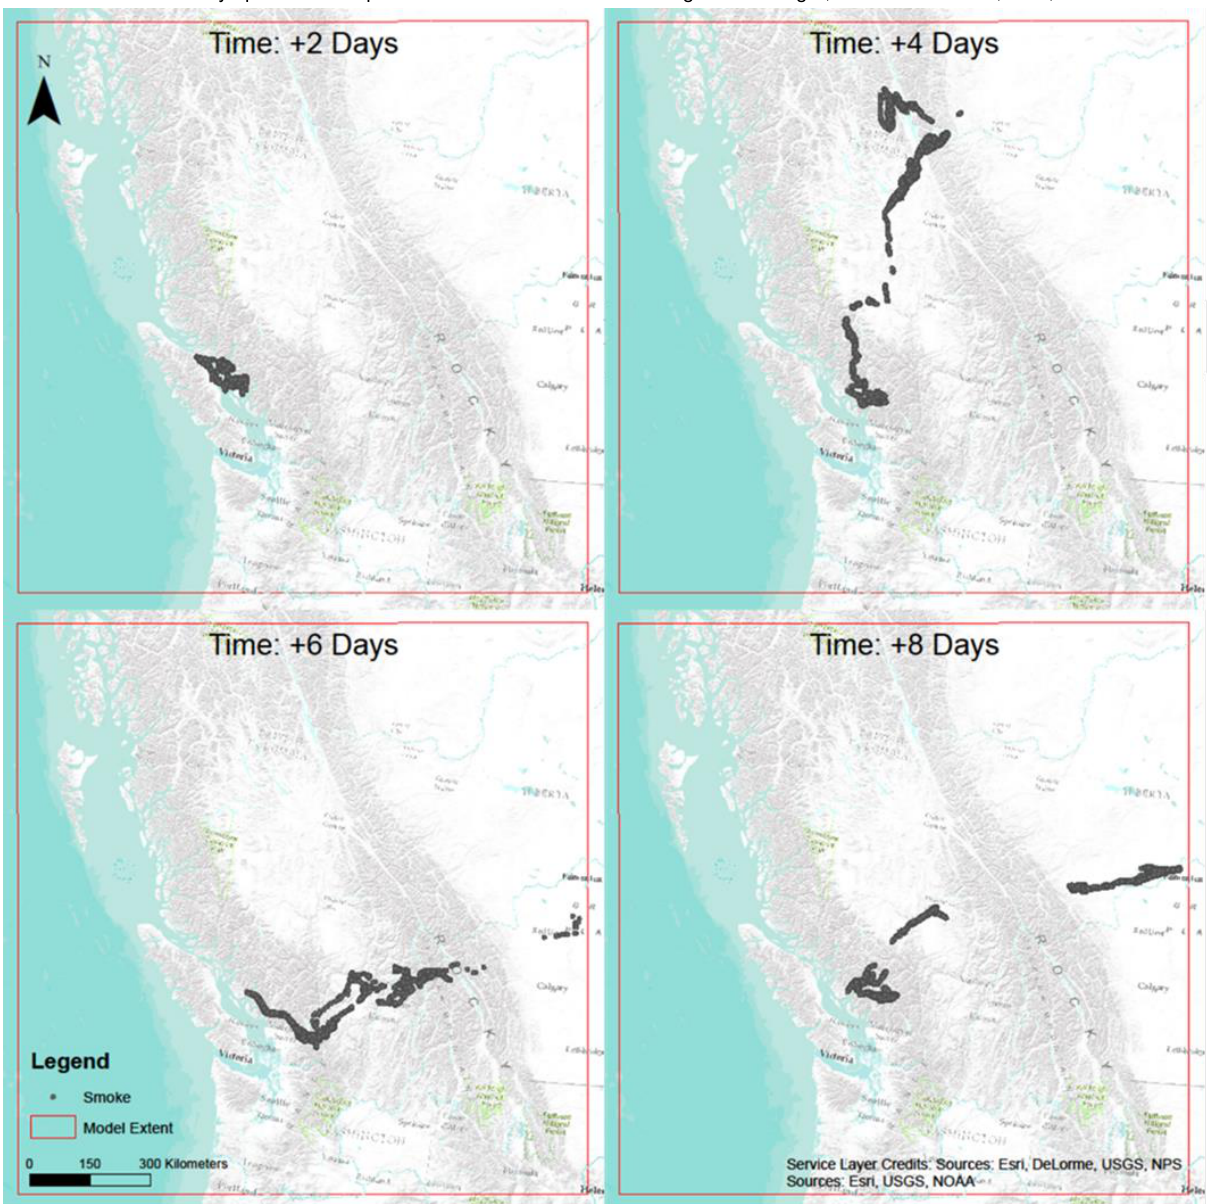
Figure 2 – Simulation results of the smoke propagation patterns initialized with the forest fire near Khartoum Lake, BC and with snapshots captured for days 2, 4, 6 and